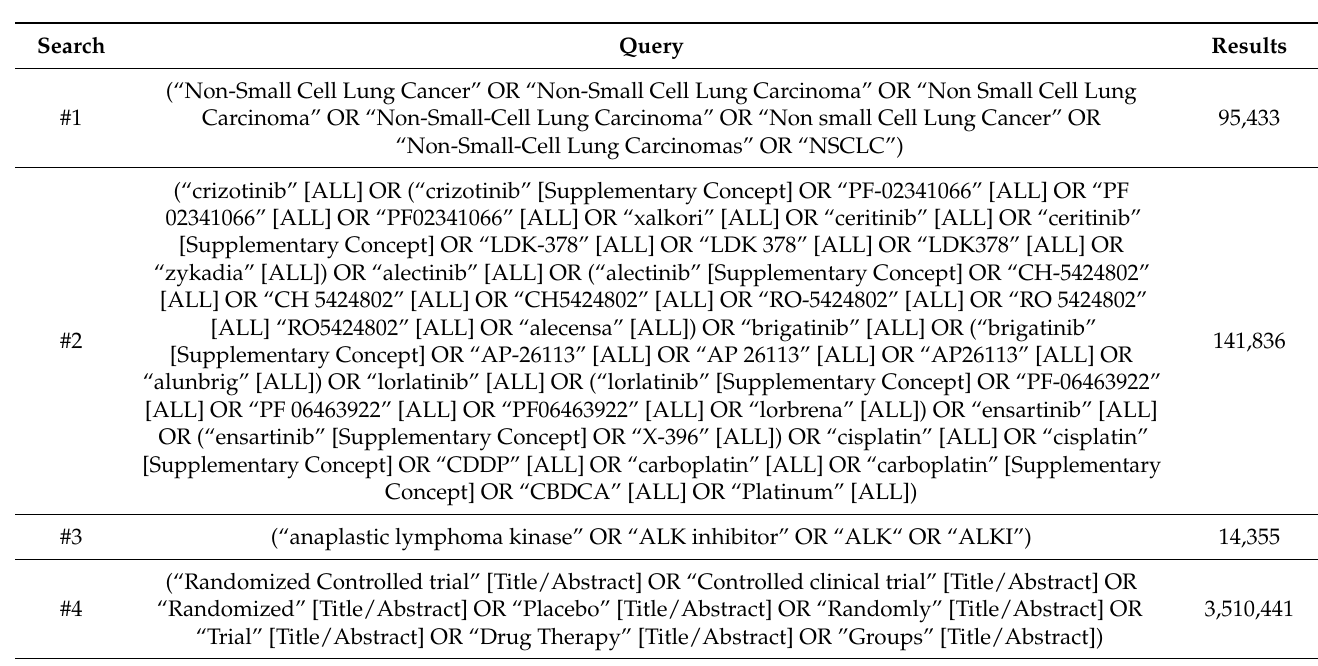
Table A1. Search Strategies in PubMed (Searched on 3 December